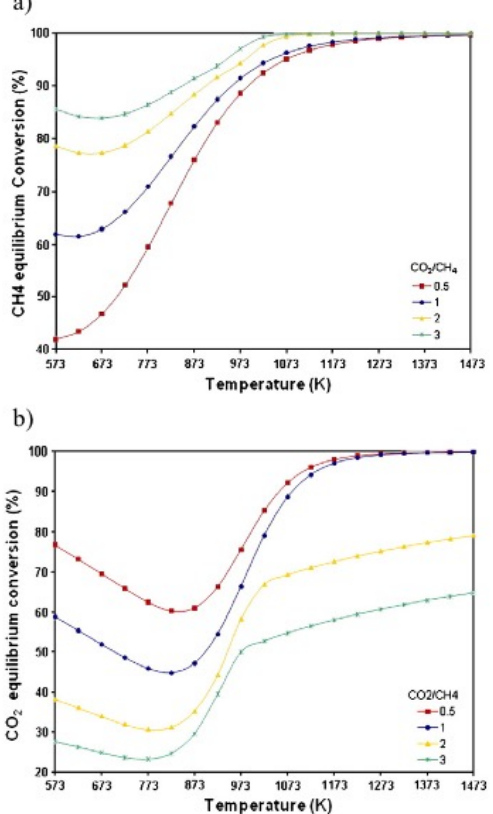
Figure 1. Equilibrium conversion of ( a ) CH 4 and ( b ) CO 2 as a function of temperature and CO 2 /CH 4 ratio at atmospheric pressure for n(CH 4 + CO 2 ) = 2 mol. Reprinted with permission from Ref. [39]. Copyright (2011) Elsevier.